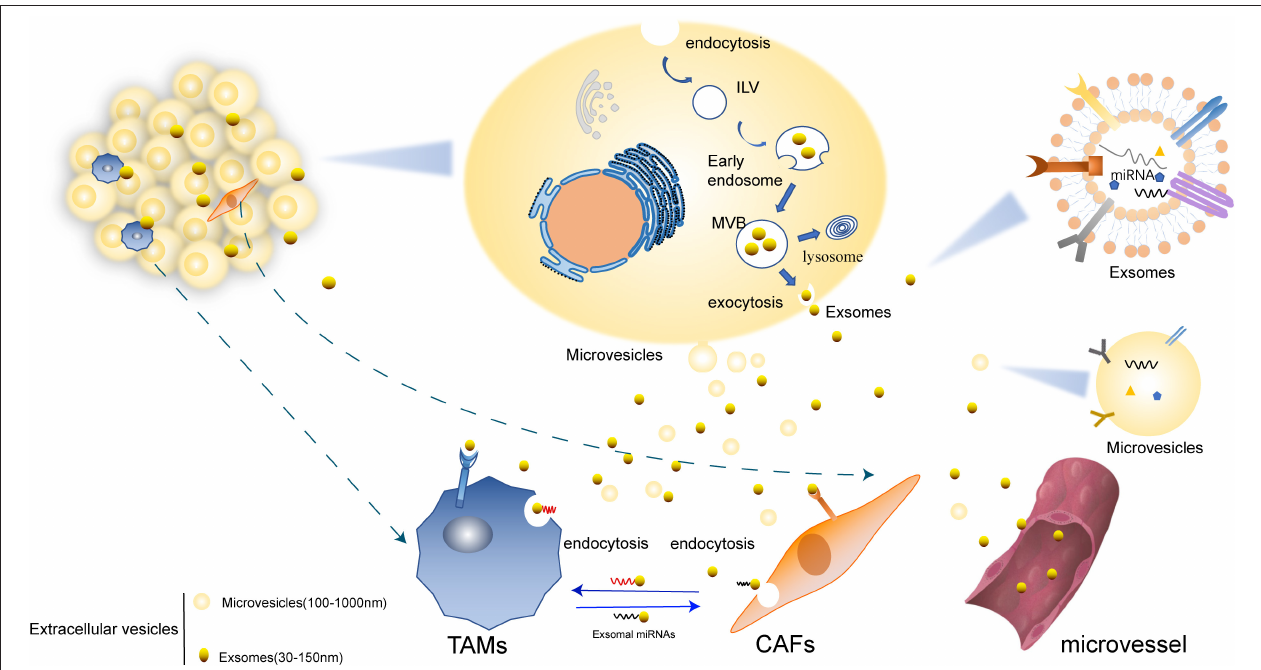
FIGURE 1 | Mechanisms of EVs secretion. (1) Microvesicles (MVs) are formed directly from the budding of plasma membrane. (2) EVs can transform firstly as intraluminal vesicles (ILVs) within the lumen of multivesicular endosomes (MVBs) and be secreted upon fusion of the plasma membrane which lastly form exosomes. (3) Exosomes mediated the crosstalk between tumor cells with TAMs and CAFs. There are miRNAs and other molecules in exosomes and are transferred in to various cells. Some exosomes are transported through micro vessel and others could be directly internalized by TAMs, CAFs, and other